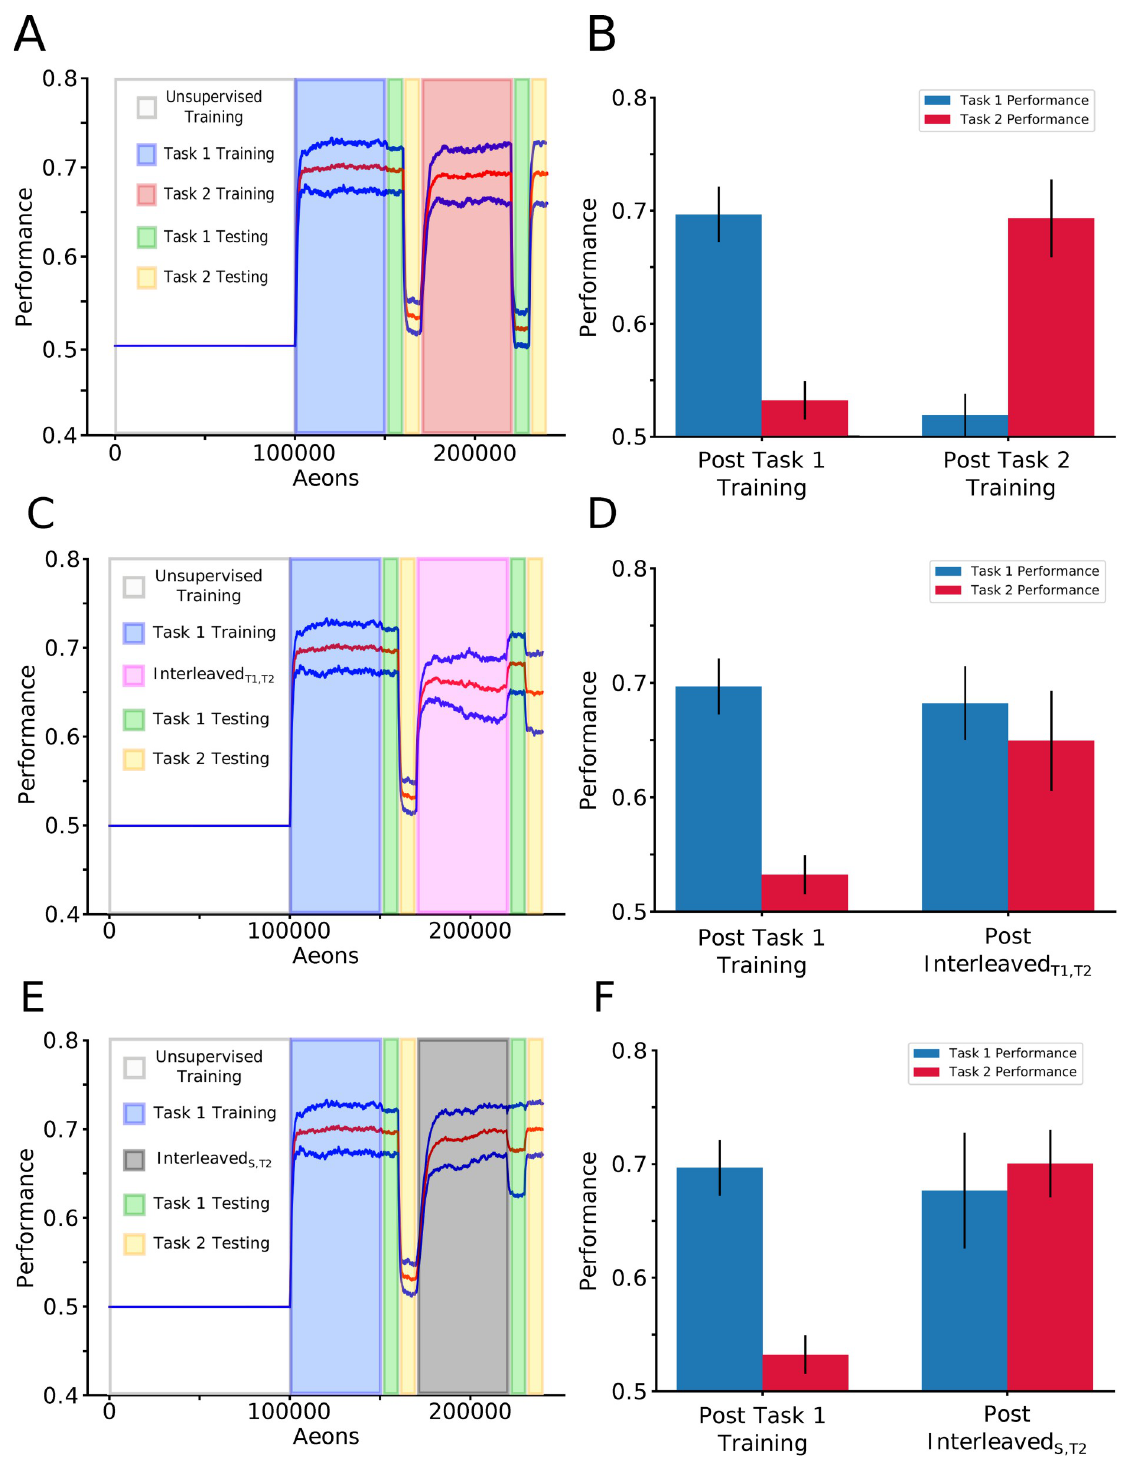
Fig 3. Sleep prevents catastrophic forgetting during new task training. (A) Mean performance (red line) and standard deviation (blue lines) over time: unsupervised training (white), Task 1 training (blue), Task 1/2 testing (green/yellow), Task 2 training (red), Task 1/2 testing (green/yellow). (B) Mean and standard deviation of performance during testing on Task 1 (blue) and Task 2 (red). Task 2 training after Task 1 training led to Task 1 forgetting. (C) Task paradigm similar to that shown in (A) but with Interleaved T1,T2 training (pink) instead of Task 2 training. (D) Mean and standard deviation of performance during testing on Task 1 (blue) and Task 2 (red).